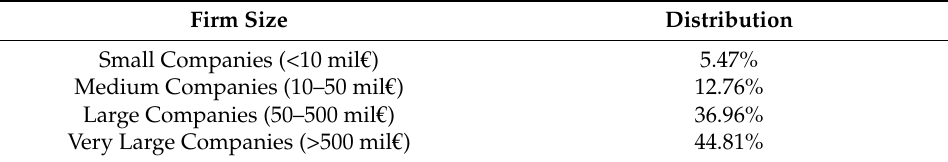
Table 3. Sample distribution in terms of firm